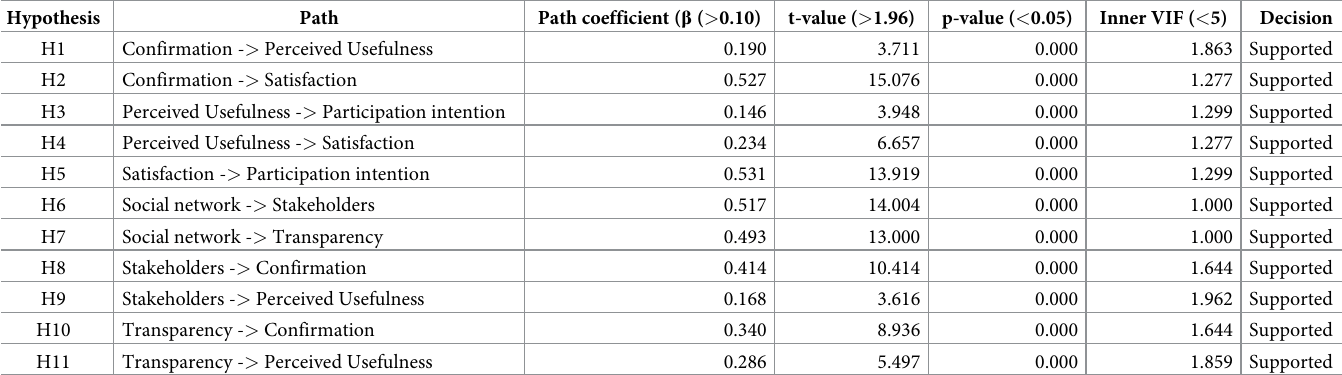
Table 6. Results of the structural model.